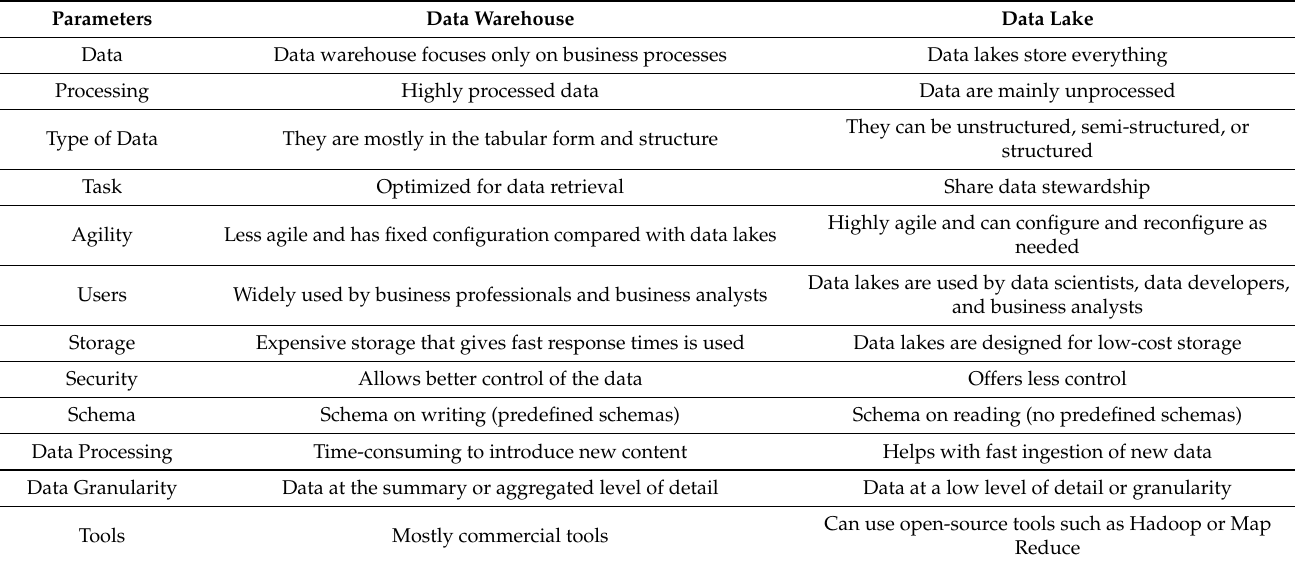
Table 1. Differences between data warehouses and data lakes.